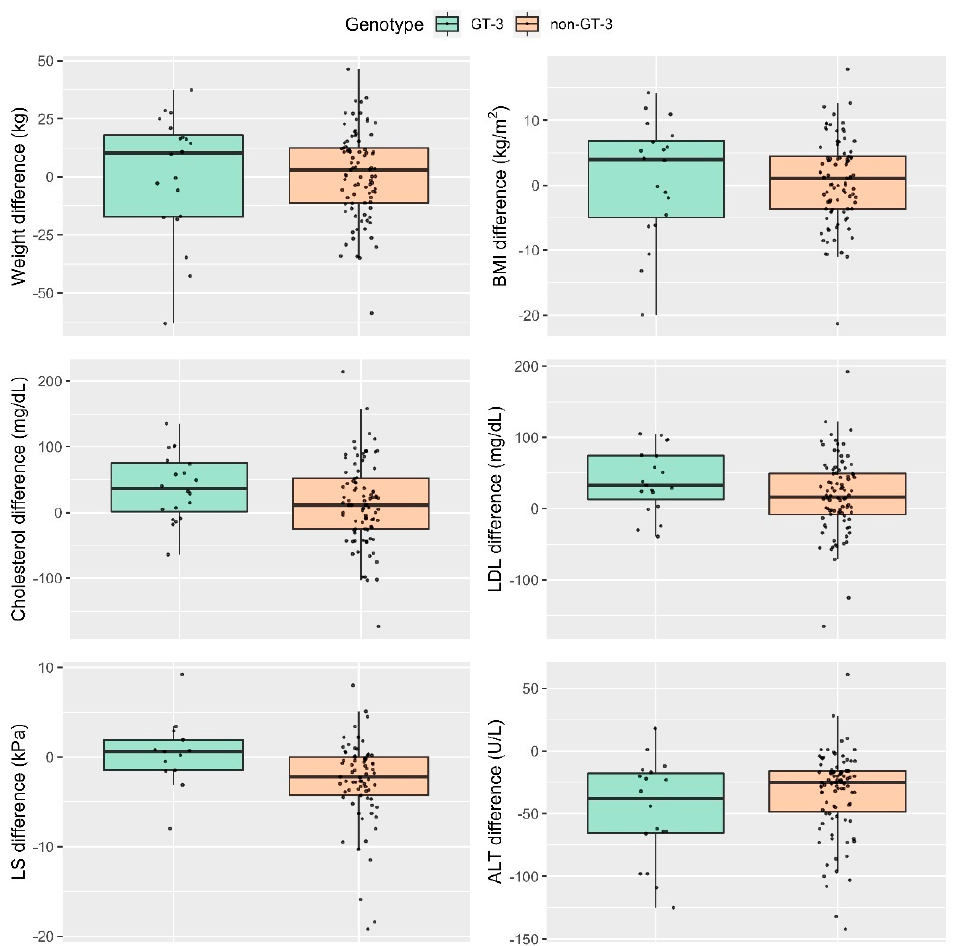
Figure 4. Differences (baseline vs. SVR12) post DAA therapy of the variables of interest in GT-3 vs. non-GT-3. Wilcoxon test: Weight difference (kg) p = 0.57; BMI difference (kg/m 2 ) p = 0.51; Cholesterol difference (mg/dL) p = 0.099; LDL difference (mg/dL) p = 0.085; LS difference (kPa) p = 0.011; ALT difference (U/L) p = 0.25.